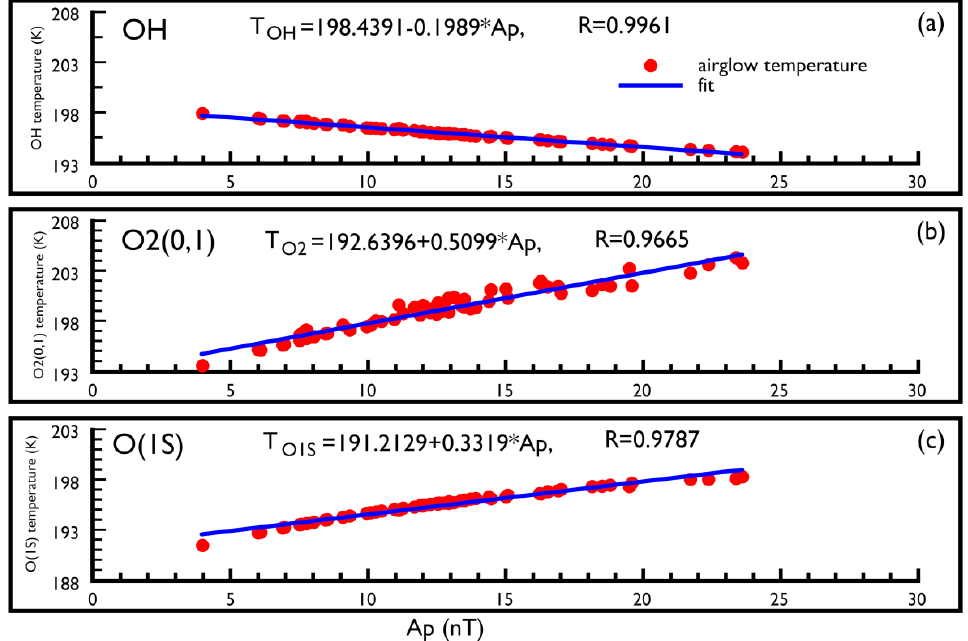
Figure 4. Linear regression of the simulated airglow temperature as a function of Ap index for S1 scenario. ( a ) For OH, ( b ) for O 2 and ( c ) for O1S temperature. The simulated airglow temperatures all display a very high correlation with the Ap index.